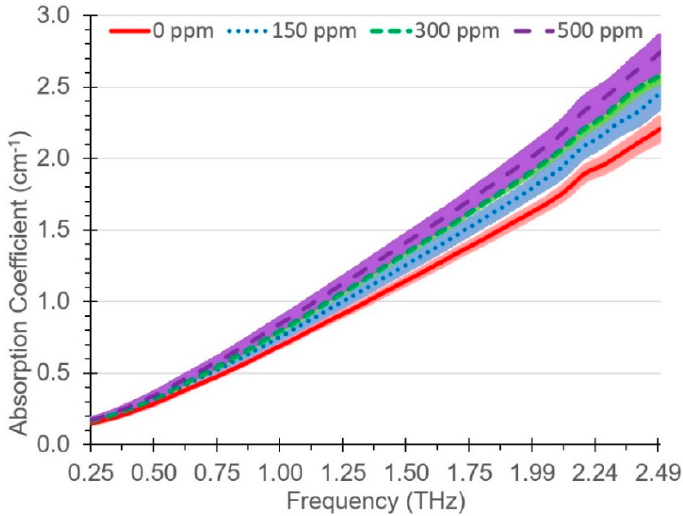
Figure 3. Mean absorption coefficient of each of four glycol contamination levels of 5W-30 gasoline/diesel engine oil with 95% confidence intervals (for clarity when hidden, 95% confidence intervals are the same above and below the mean).